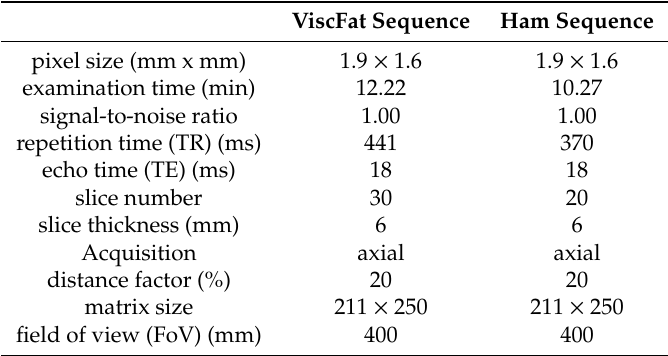
Table 2. MRI protocol of both T1-weighted sequences—“ViscFat” and “Ham”